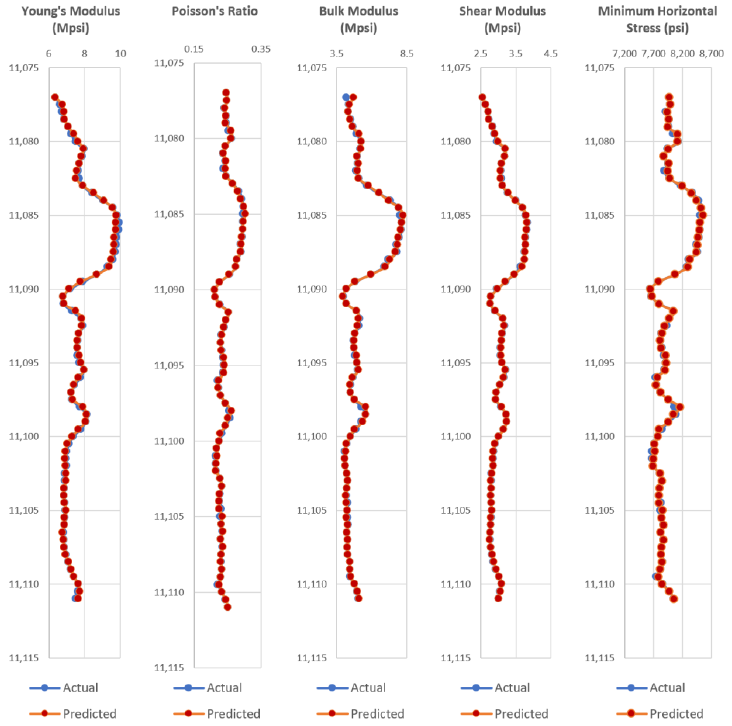
Figure A6. Actual and predicted geomechanical properties along with depth (feet) for test well 3 in Dunn County for the Middle Bakken Formation.